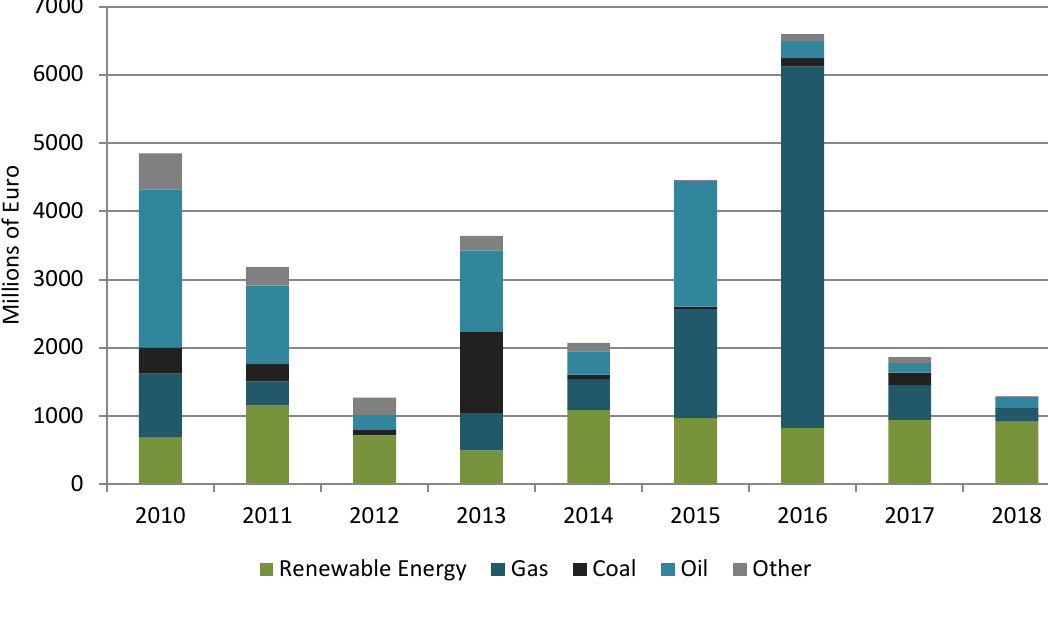
Figure 4 : German Euler Hermes export credit guarantees for energy projects by energy